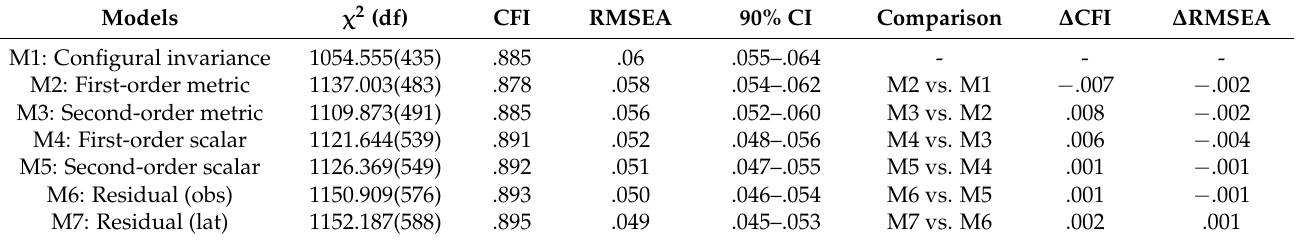
Table 5. Measurement invariance across grades.